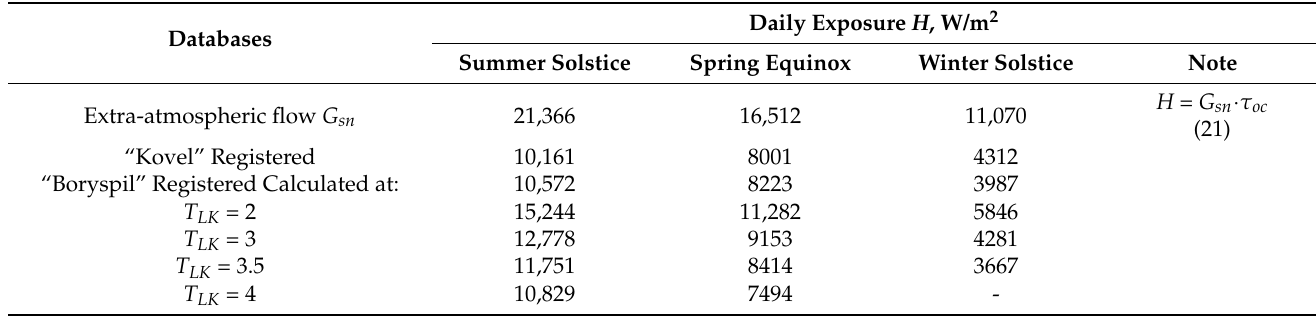
Table 4. Daily energy exposure of a direct flux on the surface, normal to solar beams (own research).